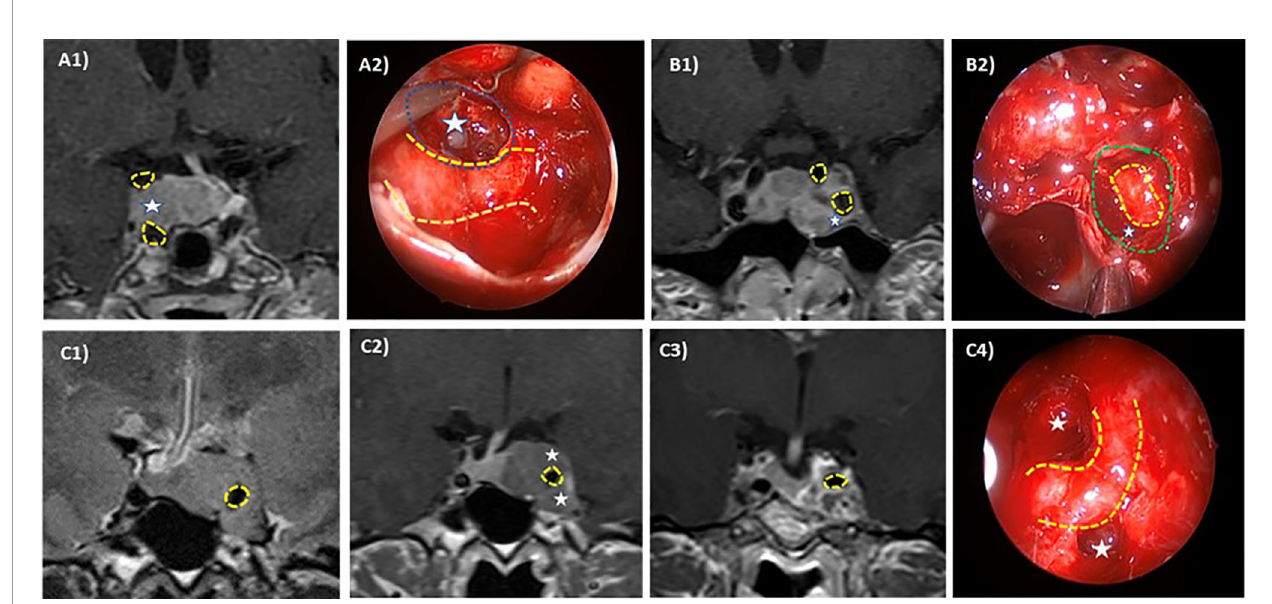
FIGURE 3 | Intraoperative – radiologic correlation of cavernous sinus invasion in pituitary adenomas. ICA is highlighted in yellow dotted line and differently affected CS compartments are pointed out (white stars). Case 1: Right superior compartment invasion of the cavernous sinus (Knosp 3A) in an acromegalic patient. Preoperative MRI (A1) and intraoperative view through a 45° endoscope (A2) after tumor resection (left cavernous sinus medial wall resected in blue dotted line). The patient was cured after surgery. Case 2: Left Inferior compartment invasion of the CS in a resistant prolactin-secreting PA (Knosp 3B). Preoperative MRI (B1) and intraoperative view through a 0° endoscope (B2) after tumor resection showing anterior CS wall resection (green dotted line). Case 3: Complete cavernous sinus invasion (Knosp 4) in an acromegalic patient. Preoperative MRI in T2 sequences (C1, C2) shows a complete ICA encasement and the postoperative coronal MRI (C3) shows a near total resection. Intraoperative view through a 45° endoscope (C4) after tumor resection showing ICA and superior and inferior compartment. No surgical cure was